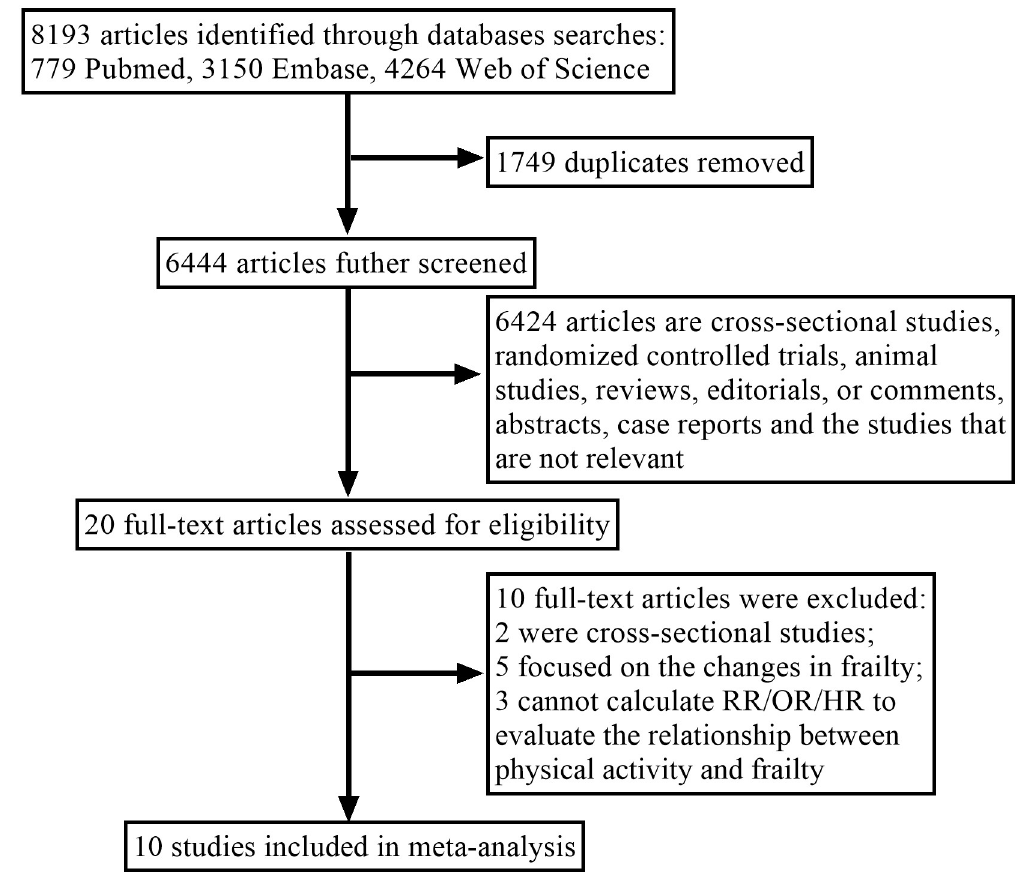
Fig 1. Flow chart of the study selection